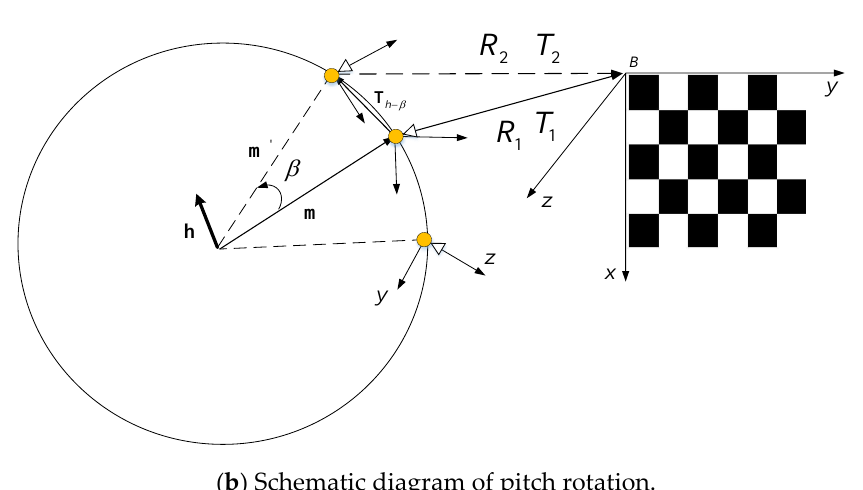
( a ) Schematic diagram of horizontal rotation.